Question: What form of chart is displayed?
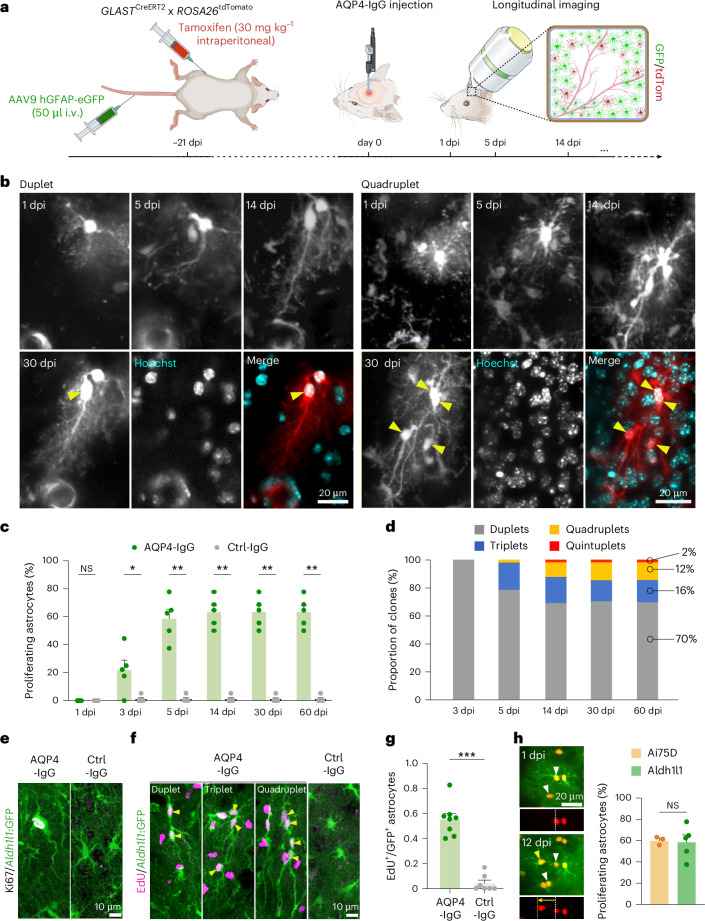
Answer: line